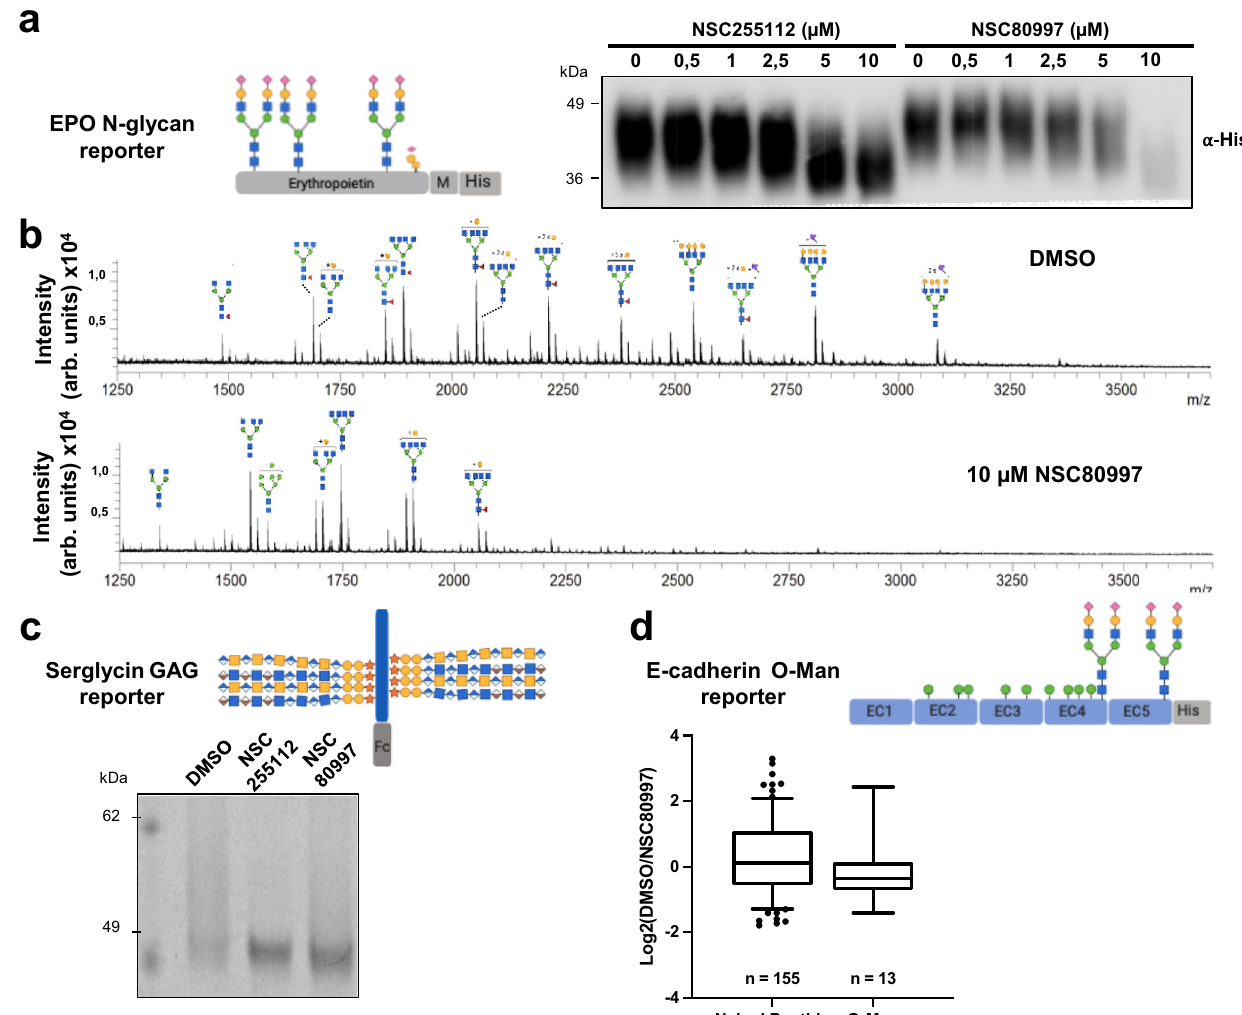
Fig. 4 | NSC80997 and NSC255112 globally remodel cellular glycosylation. a , b N-glycan analysis of an erythropoietin (EPO) reporter by western blot and MALDI-TOF analysis. a Western blot analysis of erythropoietin N-glycosylation reporter secreted by CHO WT cells treated 24h with 0 – 10 µ M NSC80997 or NSC255112 detected by staining with anti-6xHis-tag antibody. b MALDI-TOF pro- fi ling of PNGaseF released N-glycans from erythropoietin reporter secreted by HEK WT cells treated with 10 µ M NSC80997 or DMSO control. c Coomassie gel staining analysisofaglycosaminoglycan(GAG)serglycinreporterproteinsecreted